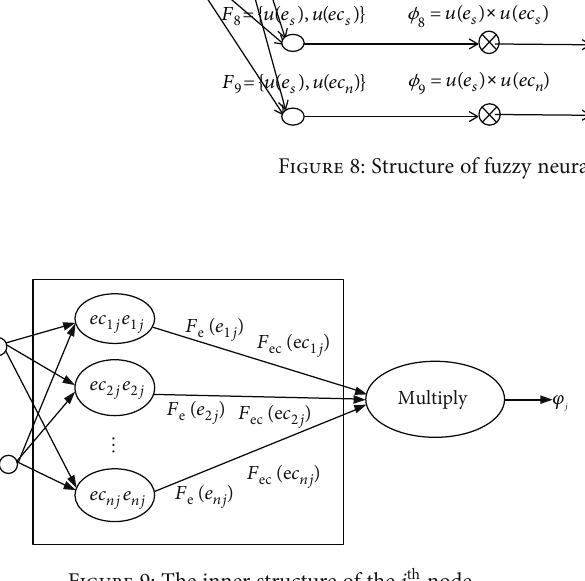
Figure 10: Structure of the action selection